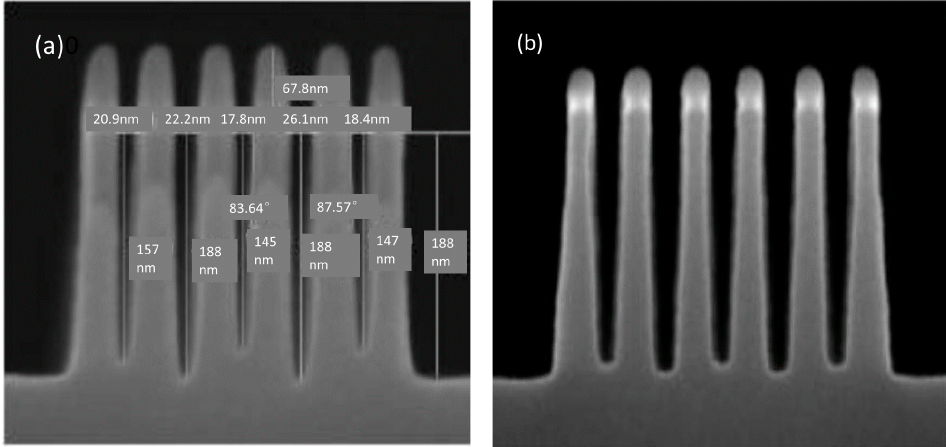
Figure 12. ( a ) Bias pulsing power effect and ( b ) Bias pulsing process. Reproduced with permission from [121]. Copyright IEEE, 2015.